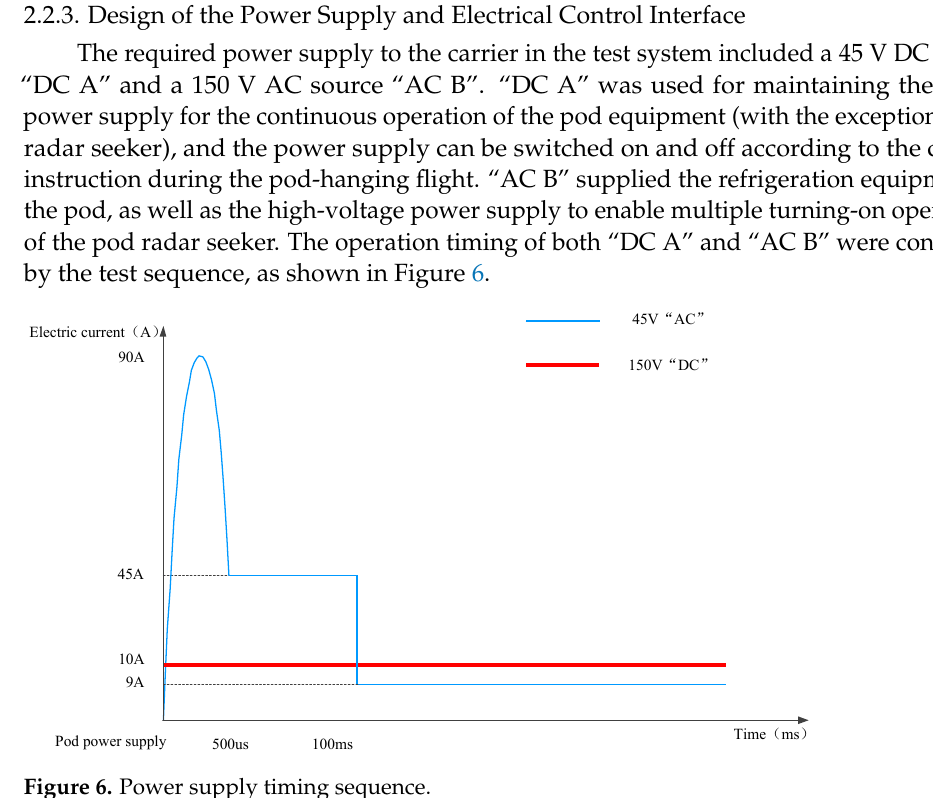
Figure 6. Power supply timing sequence.